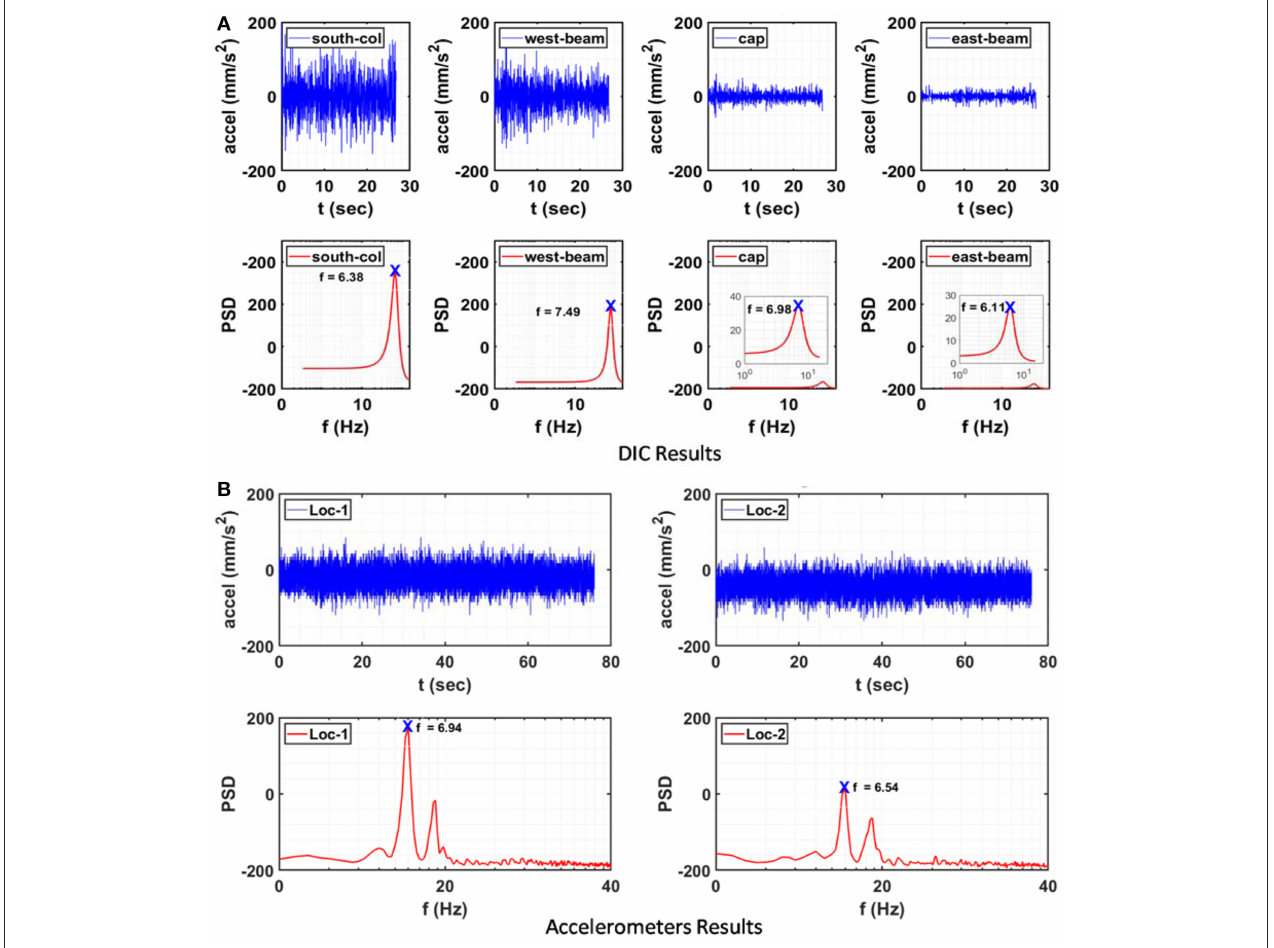
FIGURE 5 | Recorded acceleration and PSD estimate: (A) DIC signals using AR method; (B) Accelerometers using AR